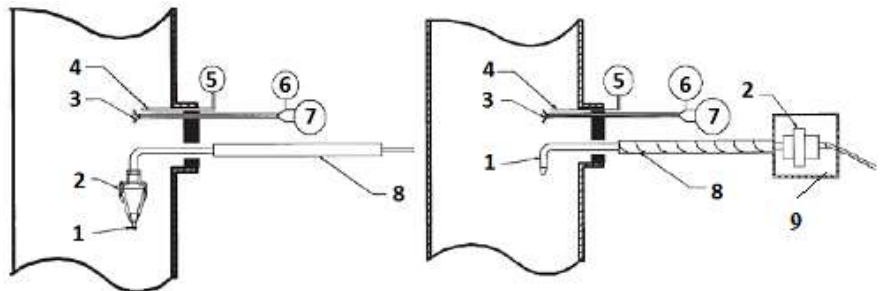
Figure 2. Example of dust sampling with ”in-stack” and ”out-stack” filtration devices. 1. sampling nozzle; 2. filter holder; 3. Pitot tube; 4. temperature sensor; 5. temperature indicator; 6. static pressure measurement; 7. dynamic pressure measurement; 8. support tube (depending on the type); 9. cooling and drying system.